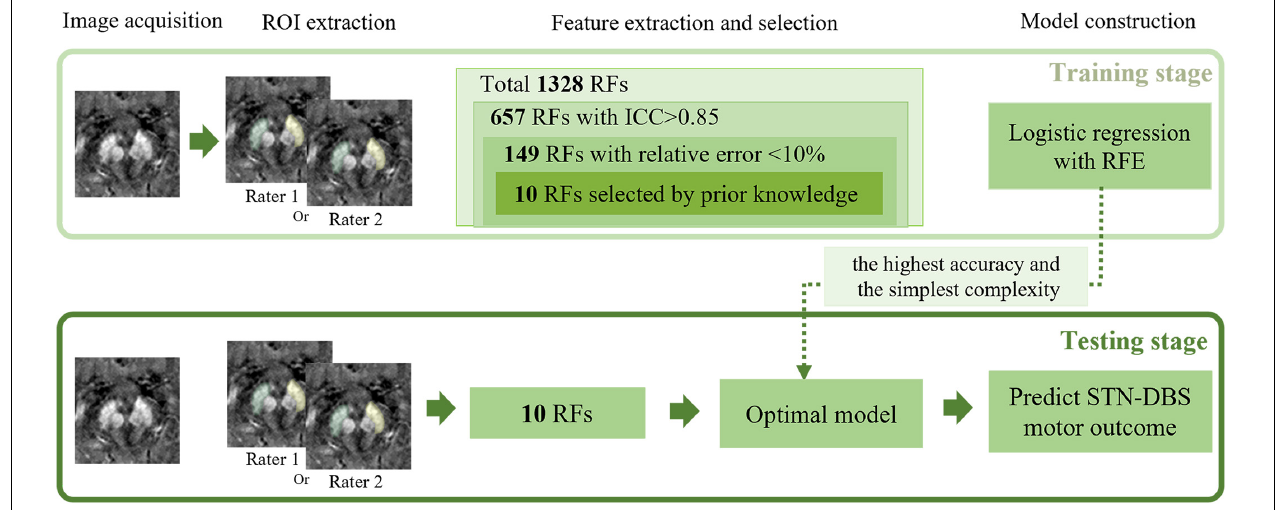
FIGURE 1 | Illustration of the processing pipeline of the RA-ML model construction. RF, radiomics features; ICC, intraclass correlation coefficient; RFE, recursive feature elimination; STN-DBS, subthalamic nucleus deep brain stimulation.